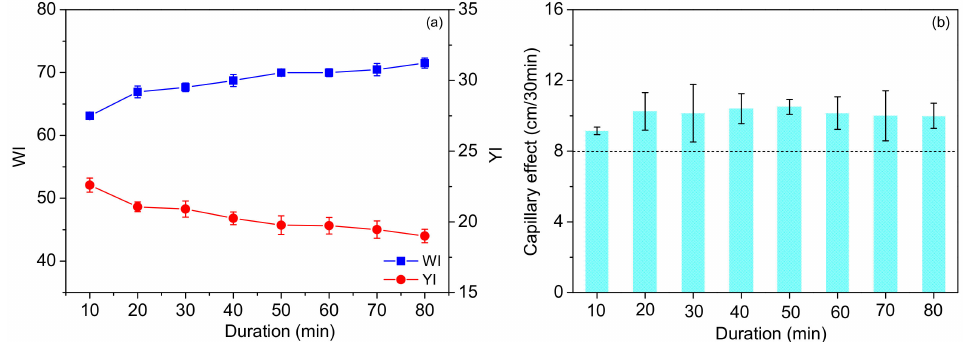
Figure 4. Effects of the duration on the WI/YI ( a ) and capillary effect ( b ) of the